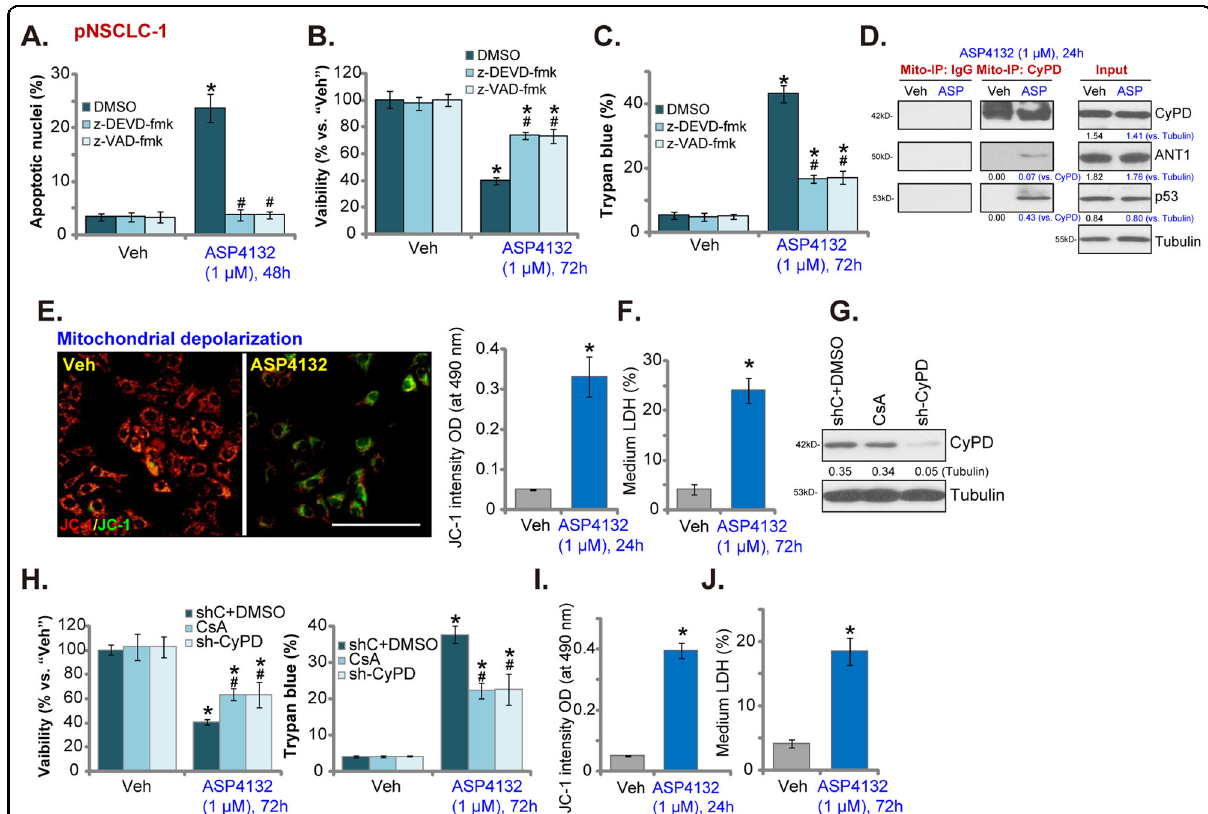
Fig. 3 ASP4132 activates programmed necrosis cascade in NSCLC cells. Primary pNSCLC-1 cells were pretreated with the caspase-3 inhibitor z- DEVD-fmk (50 μ M, 1 h pretreatment) or the pan caspase inhibitor z-VAD-fmk (50 μ M, 1 h pretreatment), followed by ASP4132 (1 μ M) treatment and cultured for applied time periods, cell apoptosis (apoptotic nuclei ratio, A ), viability (CCK-8 OD, B ) and cell death (Trypan blue positive cell ratio, C ) were tested. Primary NSCLC cells, pNSCLC-1/-2, were treated with ASP4132 (1 μ M) or the vehicle control, cells were further cultured for applied time periods, mitochondrial CyPD-p53-ANT1 association (Mito-IP, D ), mitochondrial depolarization (by measuring JC-1 green monomers intensity, E , I ) and cell necrosis (by measuring medium LDH contents, F , J ) were tested. Expression of CyPD and Tubulin in stable pNSCLC-1 cells with CyPD shRNA lentiviral particles (sh-CyPD) or cyclosporin A (CsA, 5 μ M, 24 h) treatment was shown ( F ). Control cells were treated with vehicle control plus scramble control shRNA lentiviral particles ( “ shC + DMSO ” ) ( G ); Cells were further treated with ASP4132 (1 μ M) and cultured for 72 h, cell viability (CCK-8 OD) and cell death (Trypan blue positive cell ratio) were tested ( H ). Expression of listed proteins was quanti fi ed and normalized to the loading control ( D , G ). “ Veh ” stands for the vehicle control (Saline). Data were presented as mean ± standard deviation (SD, n = 5). * p < 0.05 vs. “ Veh ” cells. # p < 0.05 vs . “ DMSO (0.2%) ” pretreatment ( A – C ). # p < 0.05 vs. “ sh C + DMSO ” cells ( H ). The experiments were repeated fi ve times with similar results detected. Scale bar = 100 μ m ( E